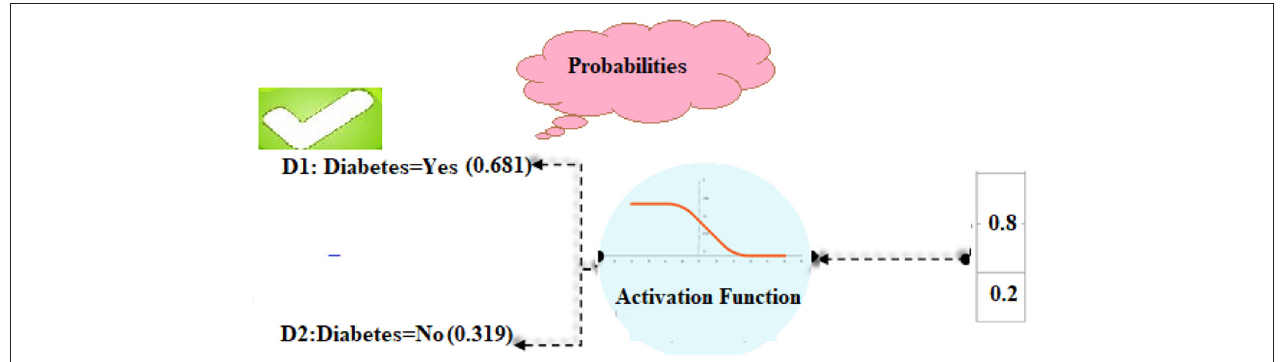
FIGURE 4 | Diabetes disease classification using the softmax function.